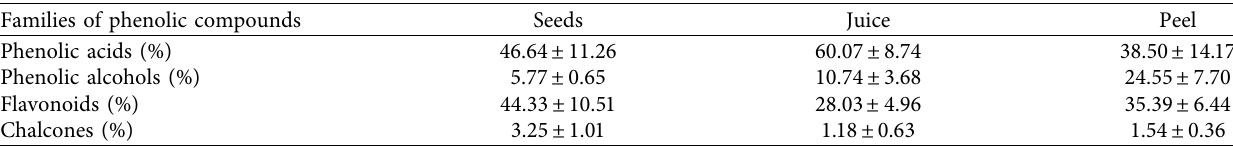
Figure 3: Example of a HPLC-DAD chromatogram obtained following analysis of O. dillenii ethanolic extract at 280nm and of standards (Std; gallic acid 1, catechin 2, 4-hydroxybenzoic acid 3, vanilic acid 4, caffeic acid 5, syringic acid 6, vanillin 7, p-coumaric acid 8, sinapic acid 9, ferulic acid 10, naringinin 11, rutin 12, salicylic acid 13, quercetin 14, cinnamic acid 15, quercetin 3-O- β -D-glucoside 16, kaempferol 17, trans-chalcon 18). Table 5: Families of phenolic compounds in ethanolic extracts of O. dillenii seeds, juice and peel. Values are means of three determi- nations ± standard errors of the mean